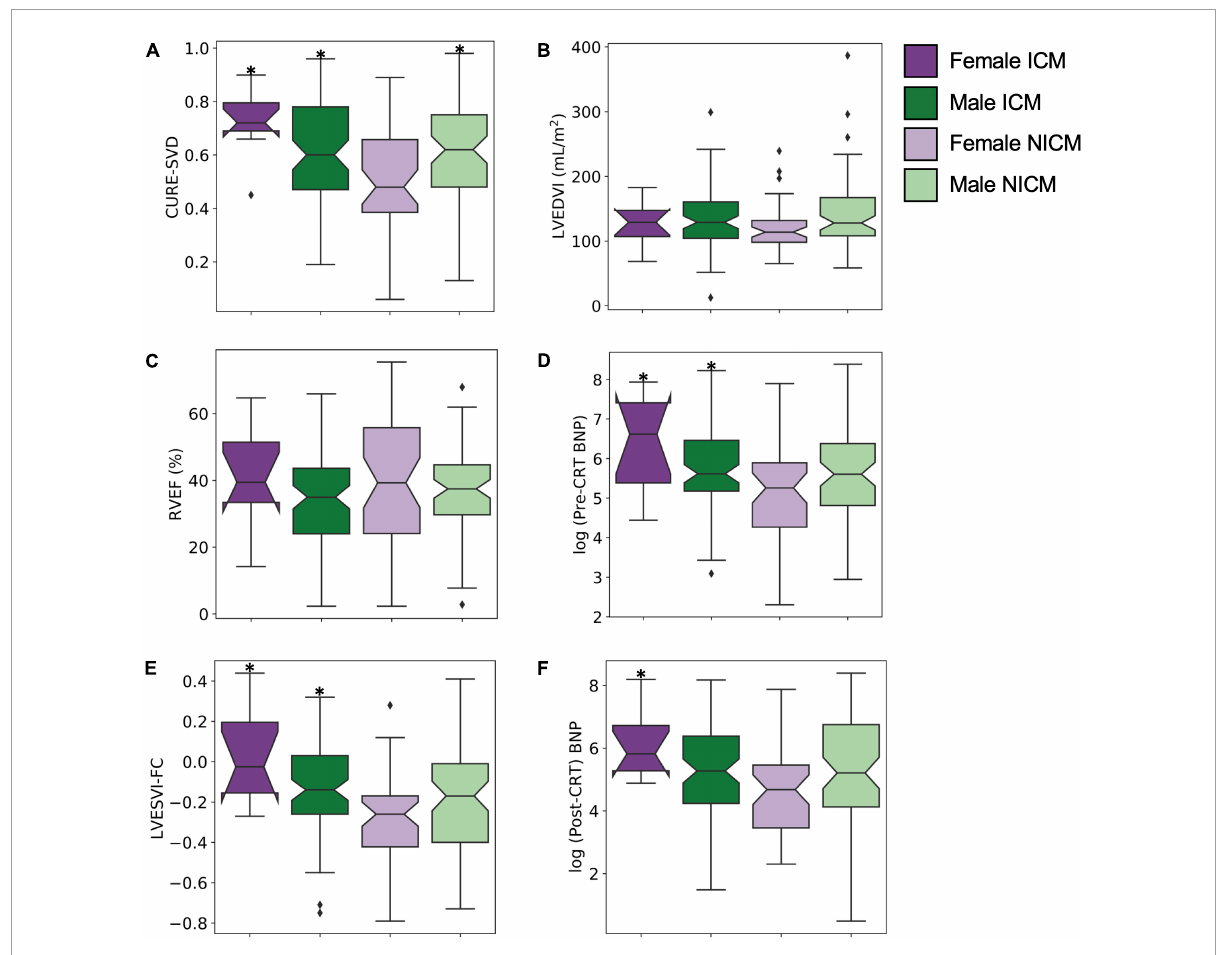
FIGURE3 Differences in dyssynchrony, LV size, RV function, hormonal activity, and CRT response measures among cohort stratified by sex and cardiomyopathy type. (A) CURE-SVD, (B) pre-CRT LVEDVI, (C) RVEF, (D) log(pre-CRT BNP), (E) LVESVI-FC, and (F) log(post-CRT BNP) were compared among the four different groups (females with ICM, males with ICM, females with NICM, and males with NICM) using ANOVA. Significant differences between group means were noted for (A) CURE-SVD ( p = 0.003), (D) log(pre-CRT BNP) ( p = 0.01), (E) LVESVI-FC ( p = 0.0006), and (F) log(post-CRT BNP) ( p = 0.05). The Tukey post hoc analysis demonstrated differences for pairwise comparisons with ∗ p < 0.05 with the NICM female group as the